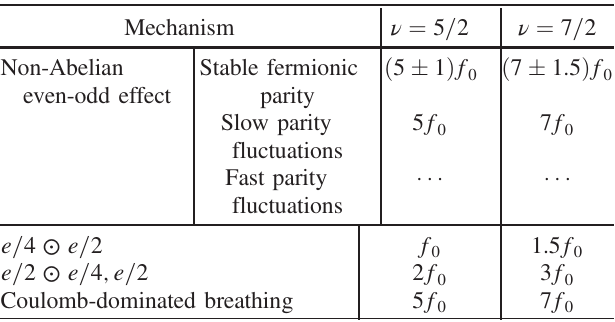
TABLE I. Possible mechanisms and spectral features of resis- tance oscillations at ν ¼ 5 = 2 and 7 = 2